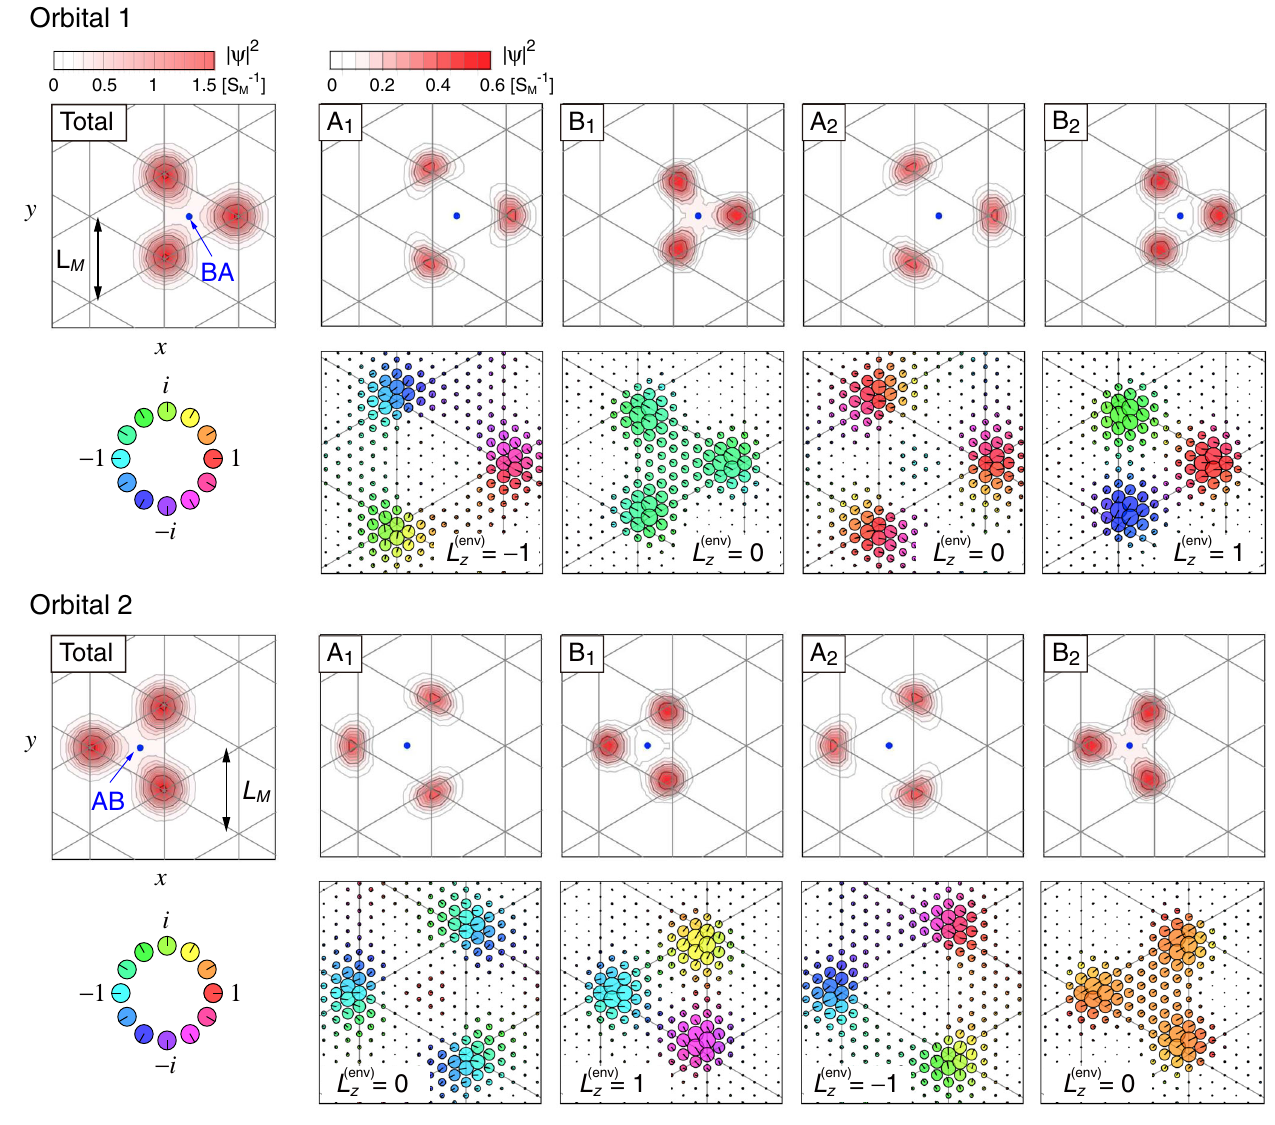
FIG. 3. Maximally localized Wannier orbitals of the valley ξ ¼ þ , in the low-energy flat band of TBG with θ ¼ 1 . 05 °. For both orbitals 1 and 2, the top five panels show the contour maps for the squared amplitudes of the total wave function and of the four sublattice components. The lower panels illustrate the phase of the envelope function on some sample points, where the amplitude is indicated by the radius of a circle, and its phase factor is shown by the direction of the bar and also by